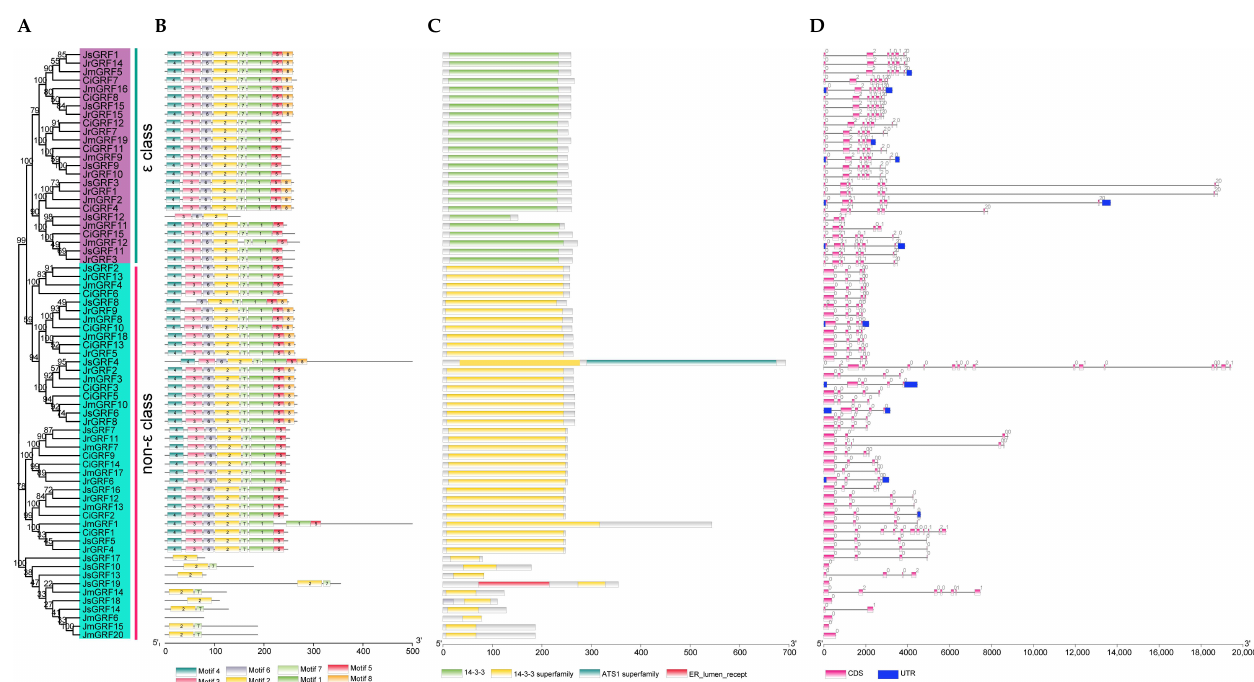
Figure 2. Phylogeny ( A ), motif analysis ( B ), main domain ( C ), and gene structure ( D ) of each GRF gene and GRF protein. Exons, introns, and upstream/downstream are represented by red, black, and blue lines, respectively.